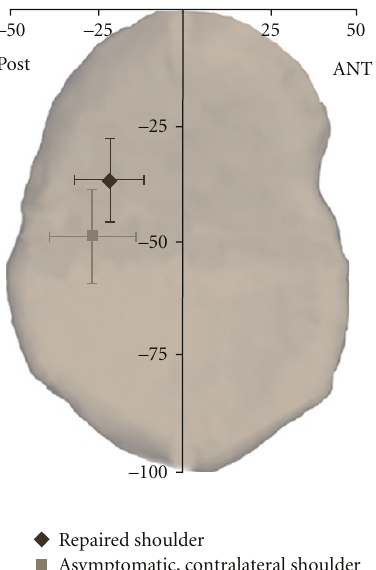
Figure 4: Average contact center position from 10 ◦ to 70 ◦ of coronal-plane abduction. Significant di ff erences in both the average S/I ( P = . 01) and A/P ( P = . 04) contact center position were detected between the repaired and contralateral shoulders. ANT: anterior, POST: posterior.